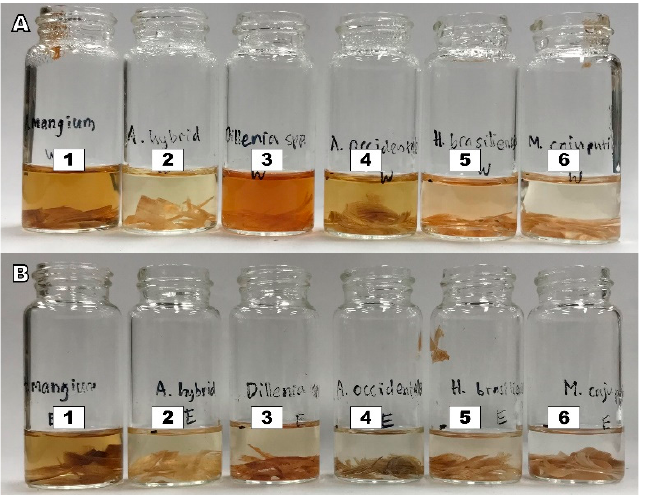
Figure 8. Water ( A ) and ethanol ( B ) extract color for Acacia mangium (1), Acacia hybrid (2), Dillenia pentagyna (3), Anacardium occidentale (4), Hevea brasiliensis (5), and Melaleuca cajuputi (6).